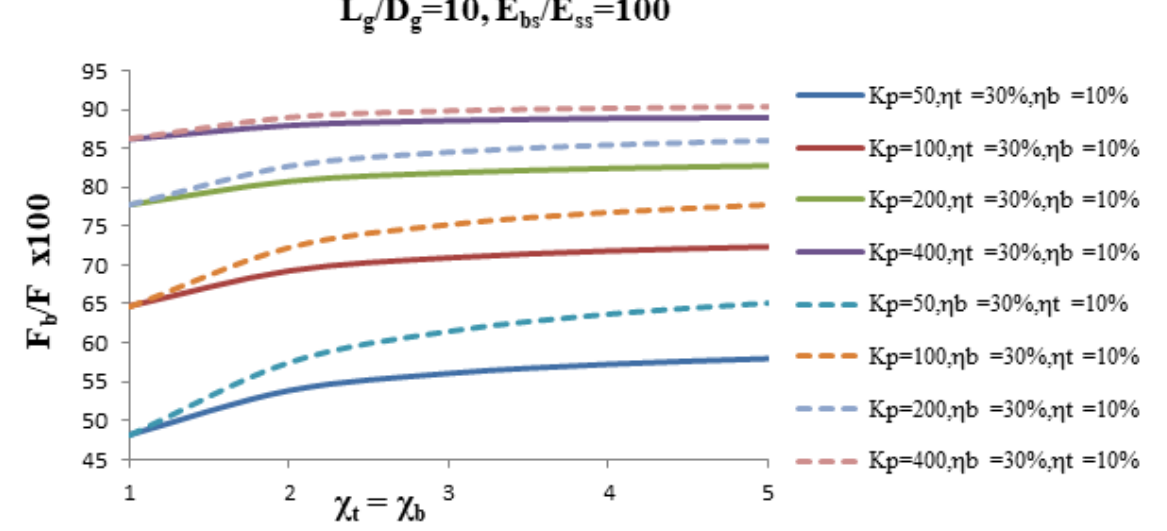
/F)x100 with strengthening factor for the top, χ b ; PLST of GP, η p